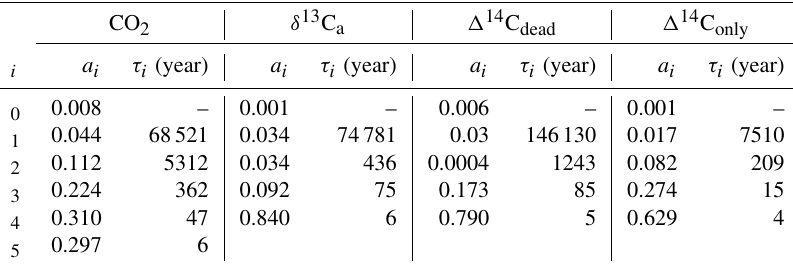
Table 2. Fit parameters for IRF( (cid:49) CO 2 ( t )) and IRF( (cid:49)δ 13 C a ( t )) of WEA 500 , IRF( (cid:49)(cid:49) 14 C a , dead ( t )), and IRF( (cid:49)(cid:49) 14 C a , only ( t )). Note that in the case of IRF( (cid:49)(cid:49) 14 C a , dead ( t )) the actual fitting was done only with data until simulation year 15000 to avoid complications from the sea-ice feedback in the control run (see main text and Fig.